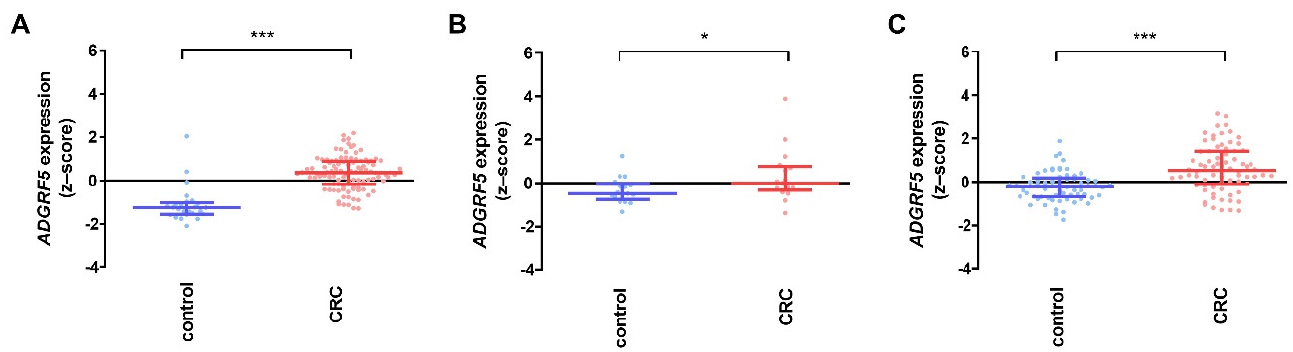
Figure 1. ADGRF5 expression pattern in the colon of controls and CRC patients derived from GSE21510 (( A ); control, n = 25; CRC, n = 104), GSE32323 (( B ); control, n = 17; CRC, n = 17), and GSE117606 (( C ); control, n = 65; CRC, n = 74) datasets. Data are presented as medians with interquartile range; * p < 0.05, *** p < 0.001.